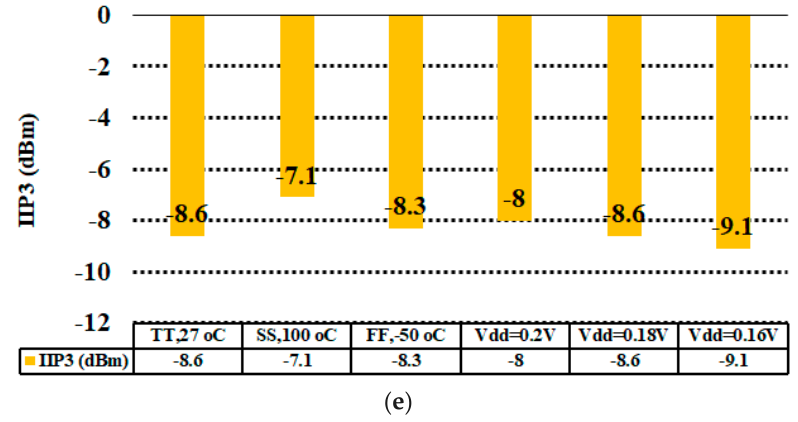
Figure 7. Simulation results of Electromagnetic (EM) and the lumped model of the transformer, ( a ) Voltage gain, NF and S 11 , ( b ) IIP3, ( c ) Noise contributors in %, ( d ) Corner simulations of ULV LNA, ( e ) IIP3 with respect to PVT variation.